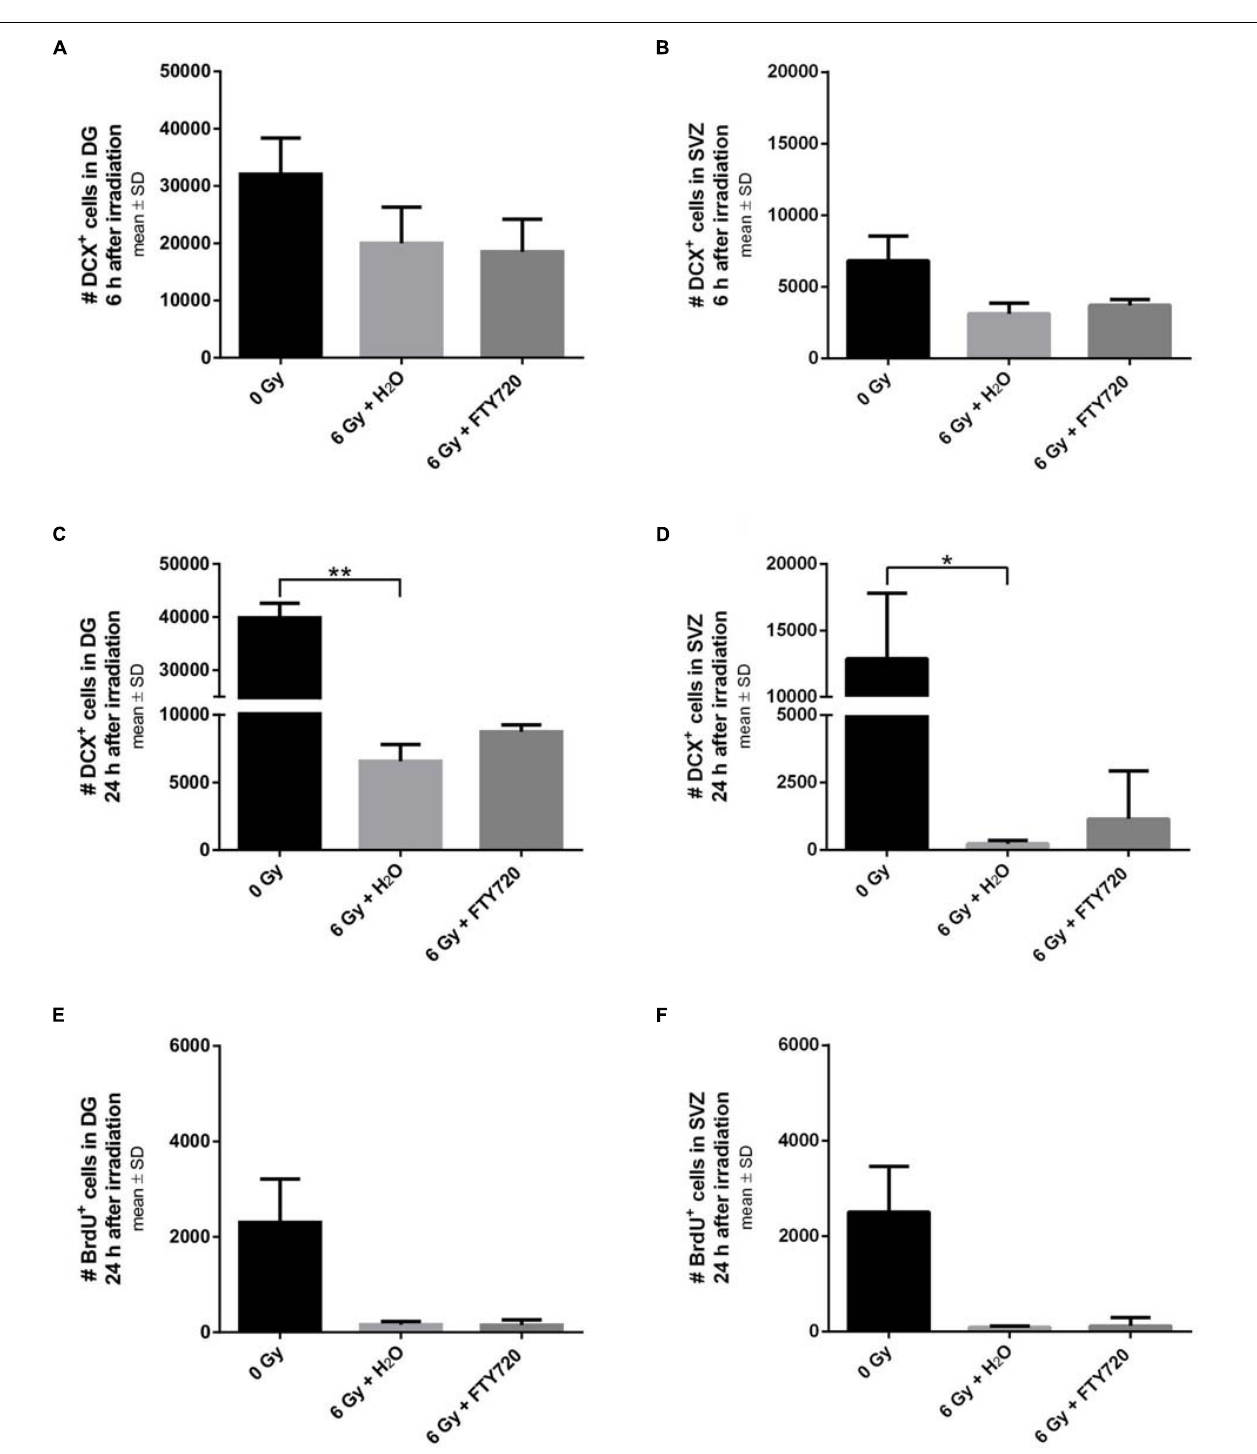
FIGURE 4 | Neurogenesis and proliferation in neurogenic niches 6 and 24 h after irradiation. Mice were treated daily with FTY720 (1 mg/kg), received a whole brain irradiation with a single dose of 6 Gy after 7 days, and were sacrificed 6 or 24 h later. (A,B) Quantification of doublecortin positive (DCX + ) cells in the DG ( n = 3 mice) and the SVZ ( n = 3 mice) 6 h after irradiation. (C,D) Number of DCX + cells in the DG (0 Gy: n = 3 mice, 6 Gy + H 2 O: n = 4 mice, 6 Gy + FTY720: n = 4 mice) and the SVZ (0 Gy: n = 3 mice, 6 Gy + H 2 O: n = 4 mice, 6 Gy + FTY720: n = 4 mice) 24 h after irradiation. (E,F) Number of bromodeoxyuridine positive (BrdU + ) cells in